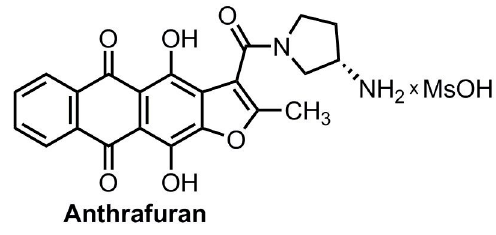
Figure 1. Anthrafuran structure.